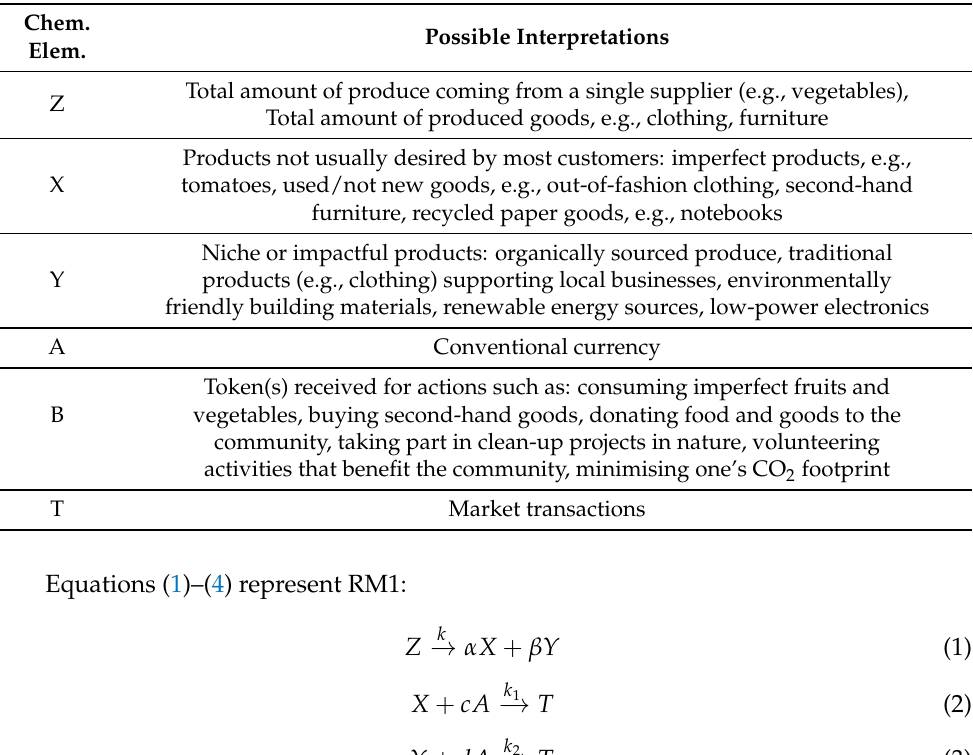
Table 1. Overview of the chemical molecules and examples of their possible interpretations.